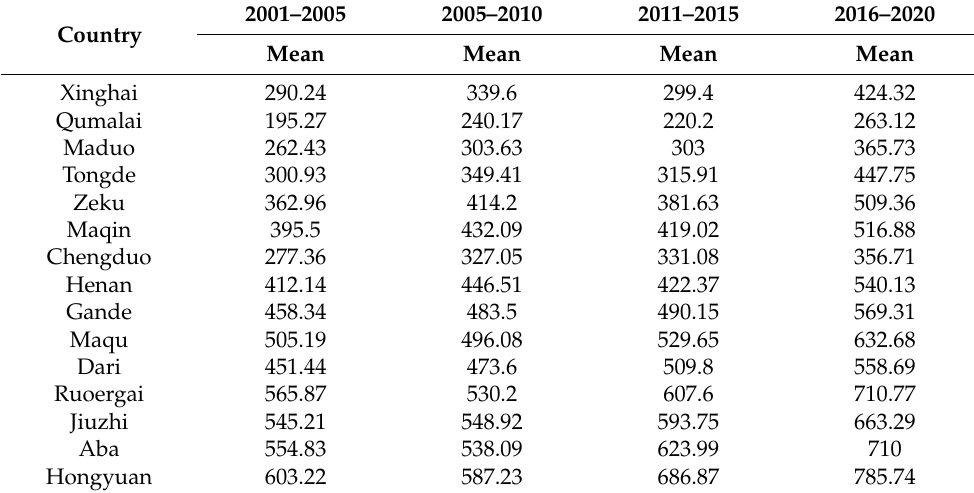
Table 3. Statistical description of water yield of counties in the HYR (unit: mm).